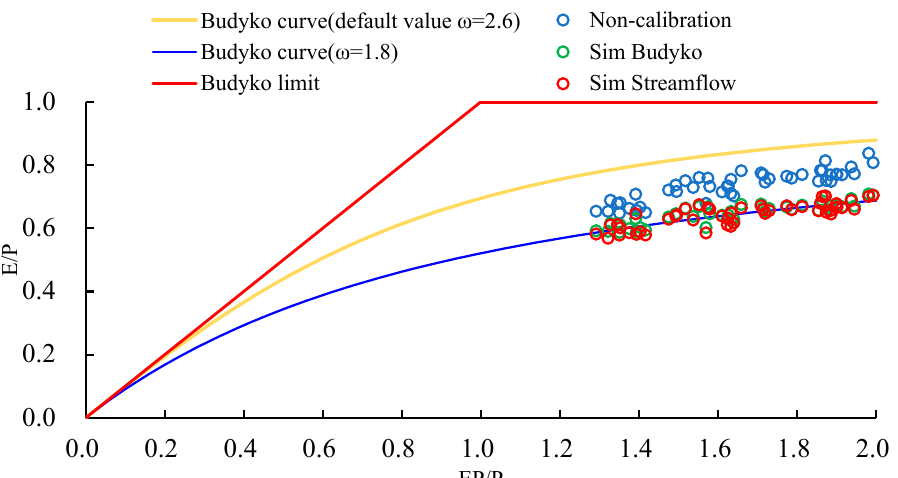
Figure 4. Budyko’s curves for the UL-MR. The dots represent the data of the basins in the UL-MR interpolated by Fu’s curves. The Budyko limit curve is dashed. The red dots represent the results of the actual streamflow calibration, the green dots represent the results of the Budyko calibration, and the blue dots represent the results of non-calibrated model.